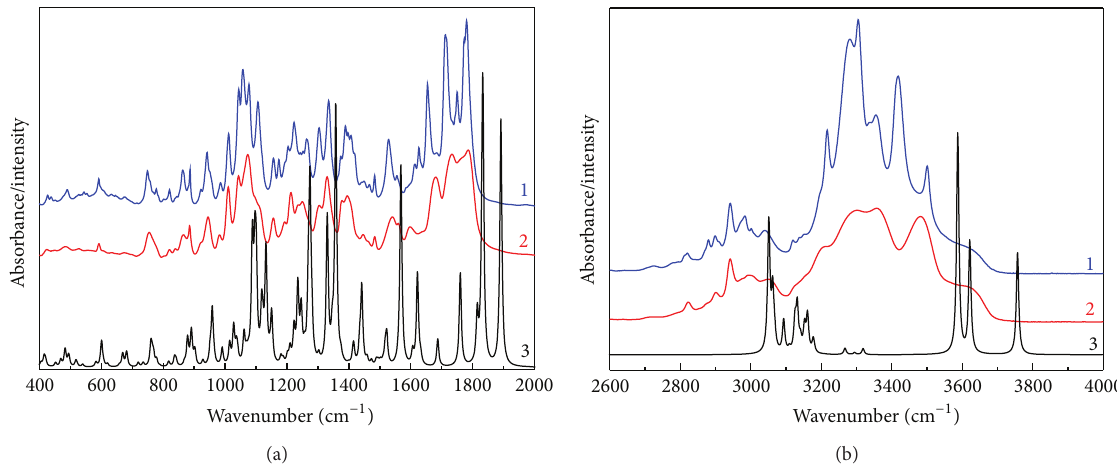
Figure 3: IR absorption spectra of cefuroxime axetil at room temperature, in polycrystalline powder: (1) crystalline form and (2) amorphous form. The corresponding calculated IR absorption spectra (B3LYP/6-31G(d,p)) were added for comparison (3).